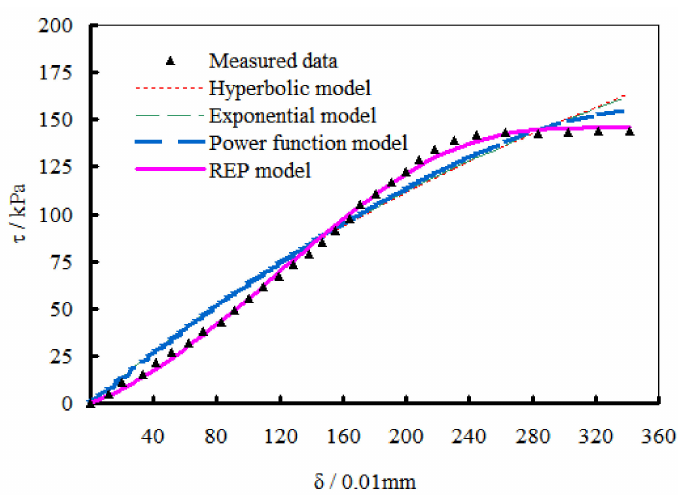
Figure 6. τ - δ curve for mix ratio with 7% cement